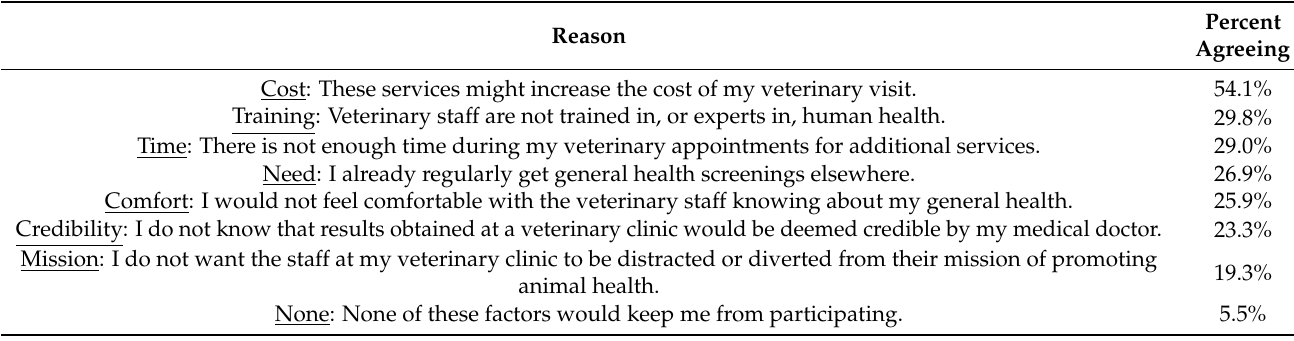
Table 6. Reasons why dog owners (n = 1028) would not participate in joint human–animal health activities.